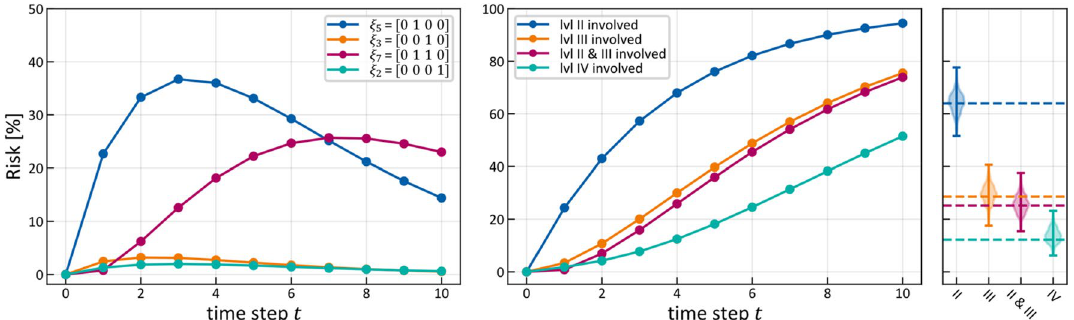
Figure 7. (left) Probability of certain hidden state vs time; (middle) Probability of LNL’s involvement marginalized over the other LNL’s involvement vs time; (right) The same probabilities as in the middle, but also marginalized over the time-prior and depicted as violin plots. The dashed lines represent the prevalence in the dataset 8 that was used for